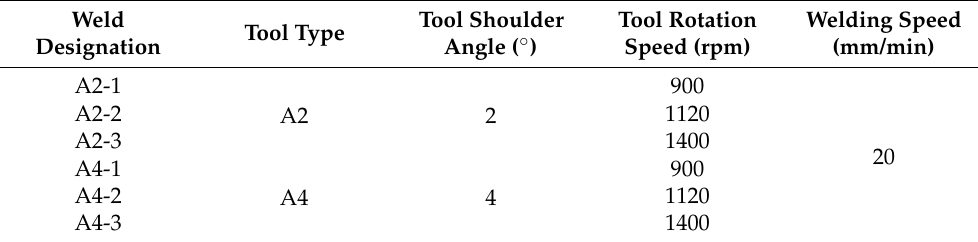
Table 3. Tools and parameters designation